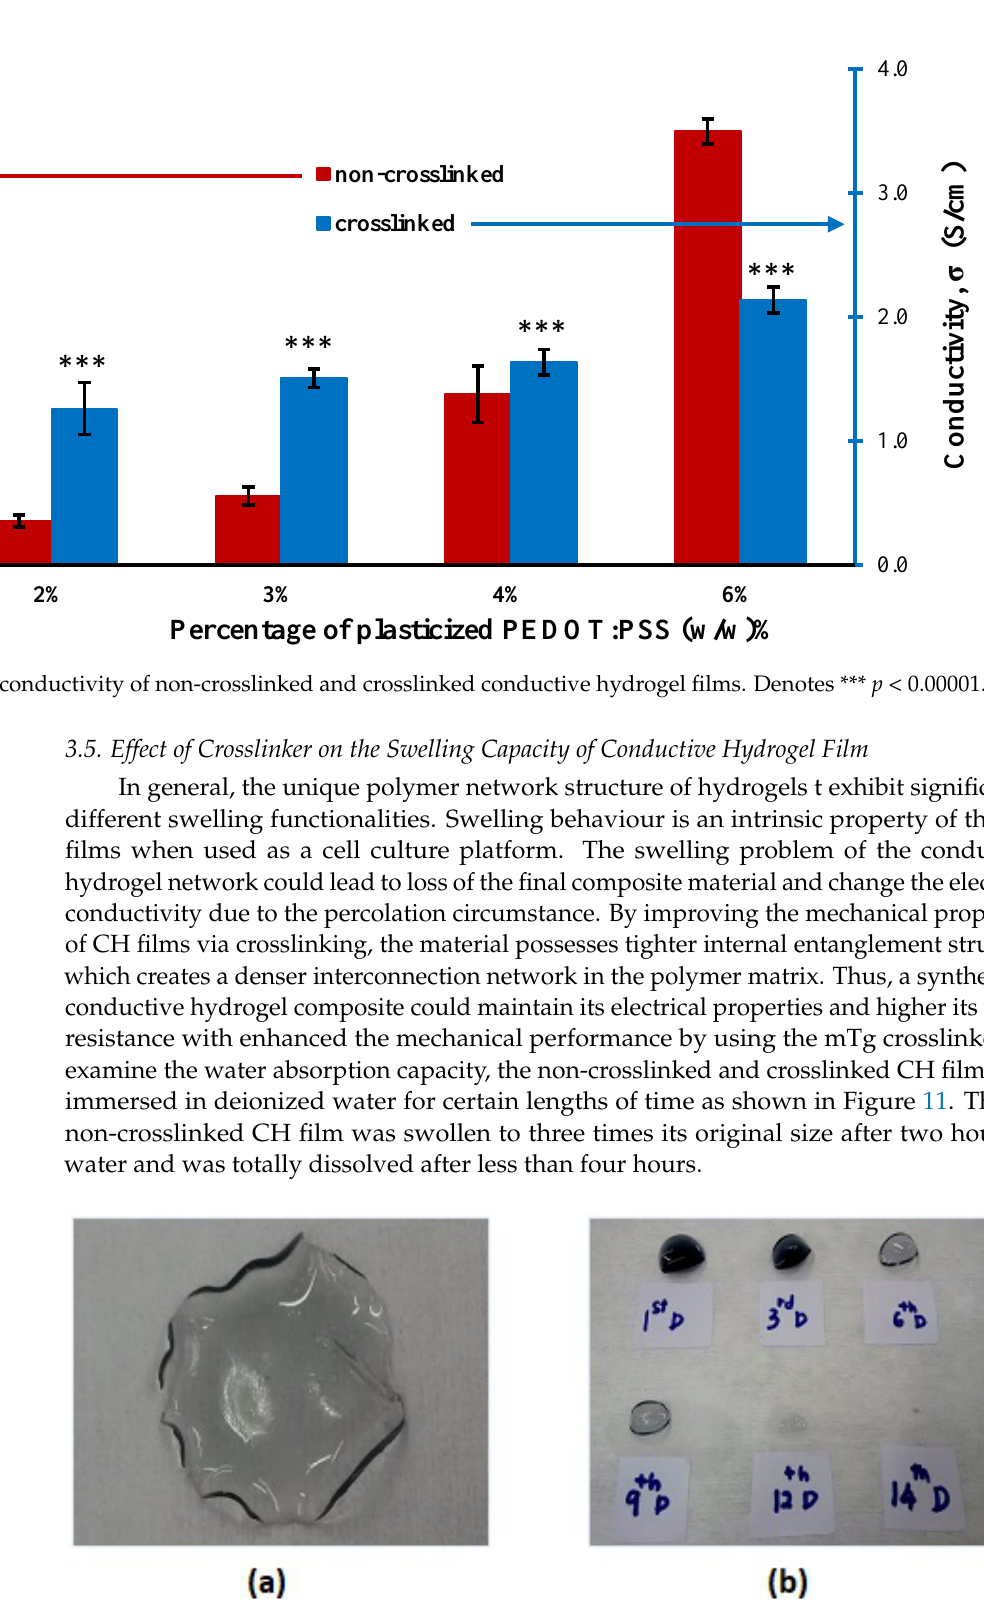
Figure 11. Swelling behaviour of ( a ) non-crosslinked conductive hydrogel film and ( b ) crosslinked conductive film.